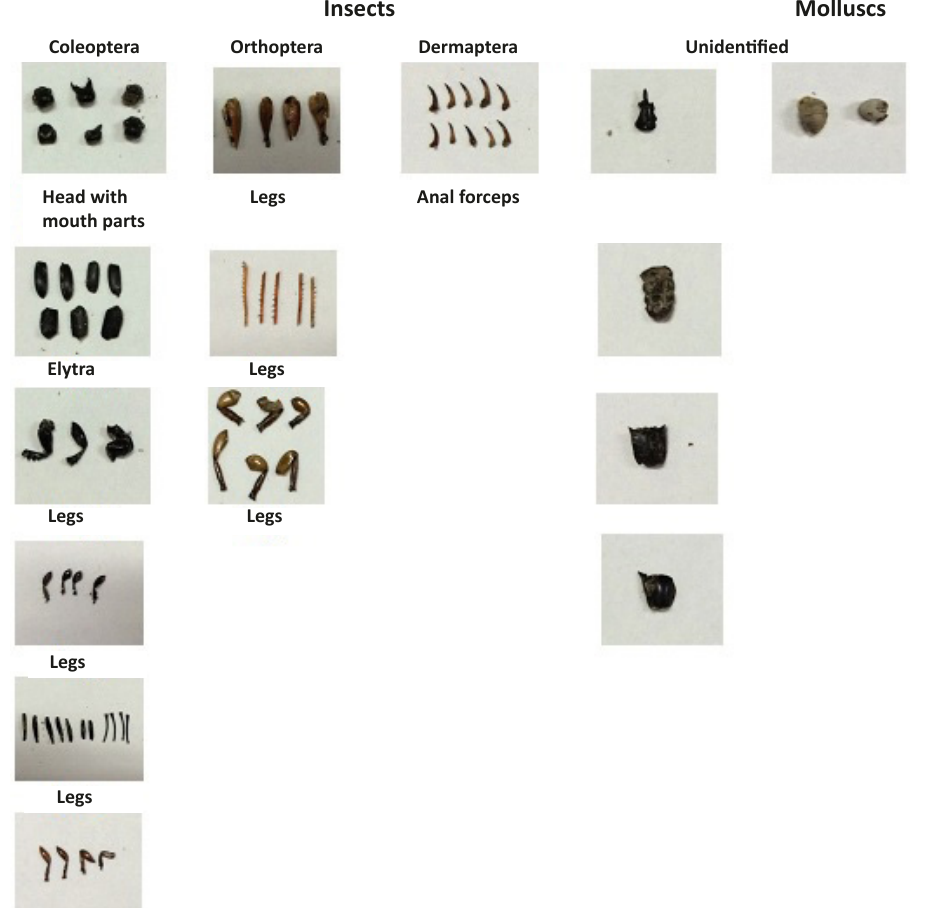
Figure 7 . The parts of insects of different orders, molluscs and unidentified parts found in pellets of Spotted Owlet. © R.